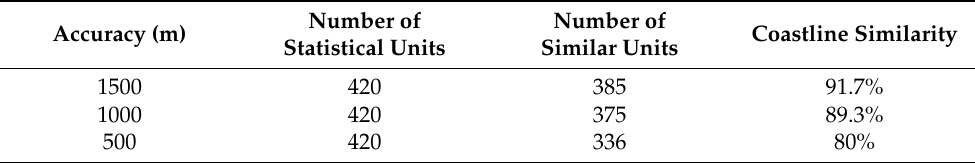
Figure 8. Simulated coastline results: comparison of the simulation results of the modern coastline with the real coastline, and enlargement of three areas used for display. Table 3. Accuracy of the simulated coastline: Similarity of simulated coastline under accuracy of 500, 1000, and 1500 m. Accuracy (m)